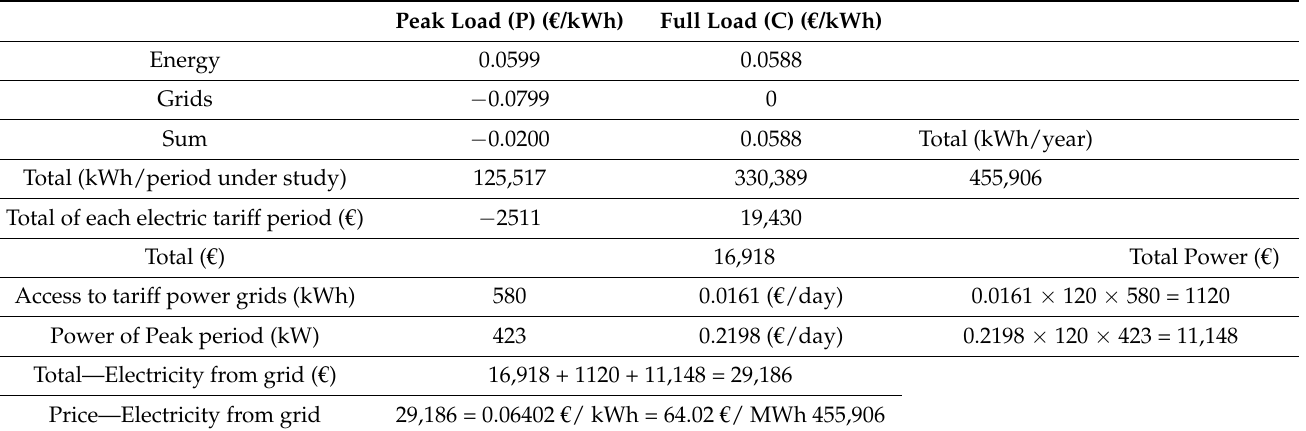
Table 16. Calculation of the average price of electricity from the factory network of the photovoltaic system using an invoice for the year